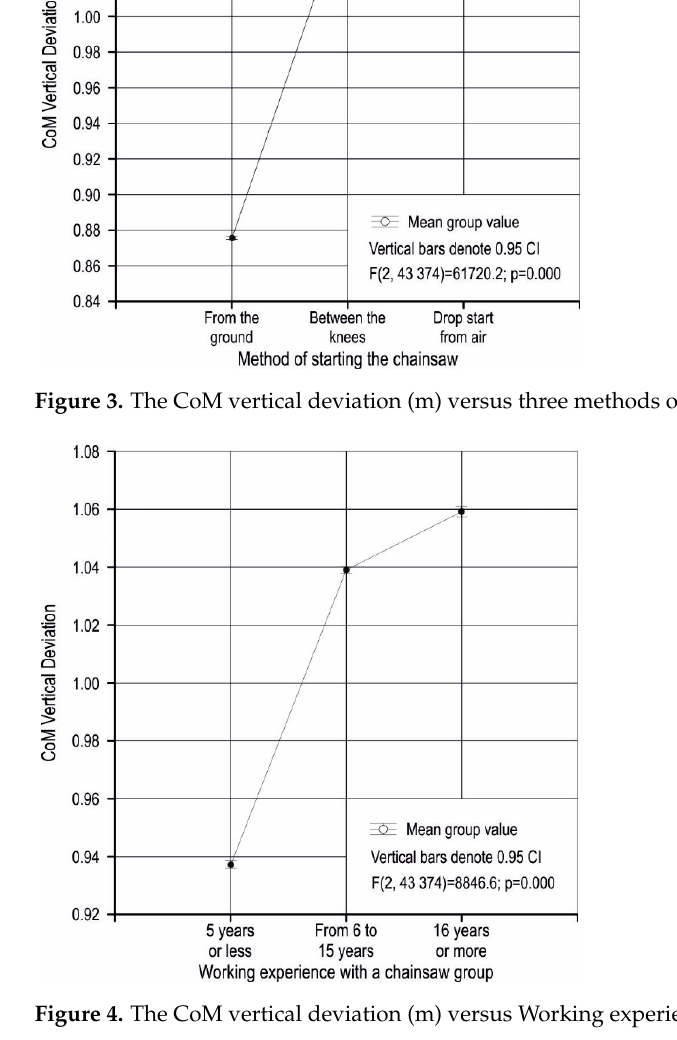
Table 6. The Mann-Whitney U test results for CoM vertical deviation.